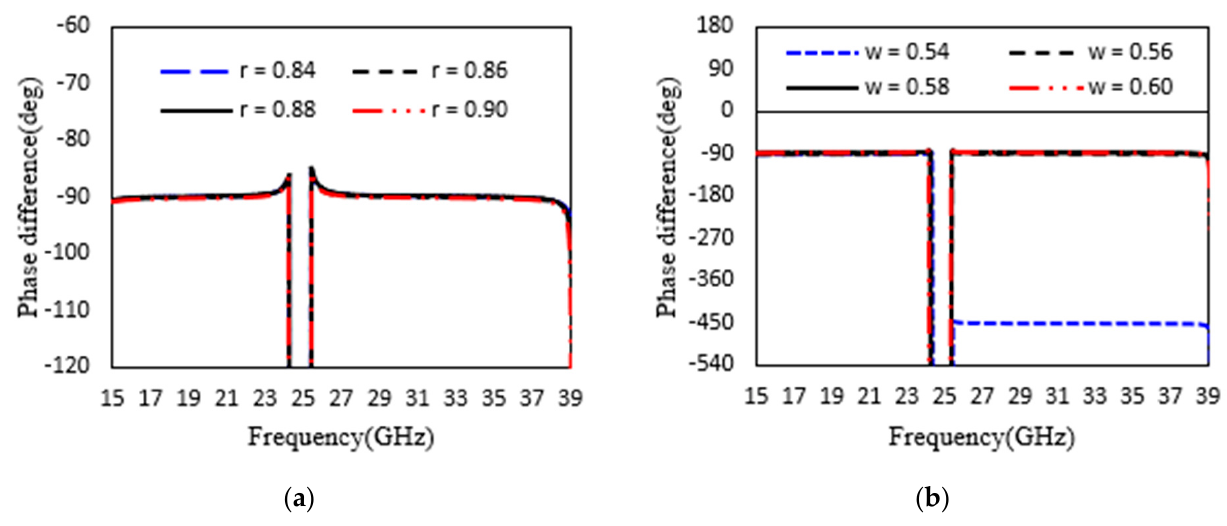
Figure 5. The simulated parametric result of phase difference (degree) at y -polarized incidence. ( a ) r (0.84 mm to 0.90 mm) and ( b ) w (0.54 mm to 0.60 mm).